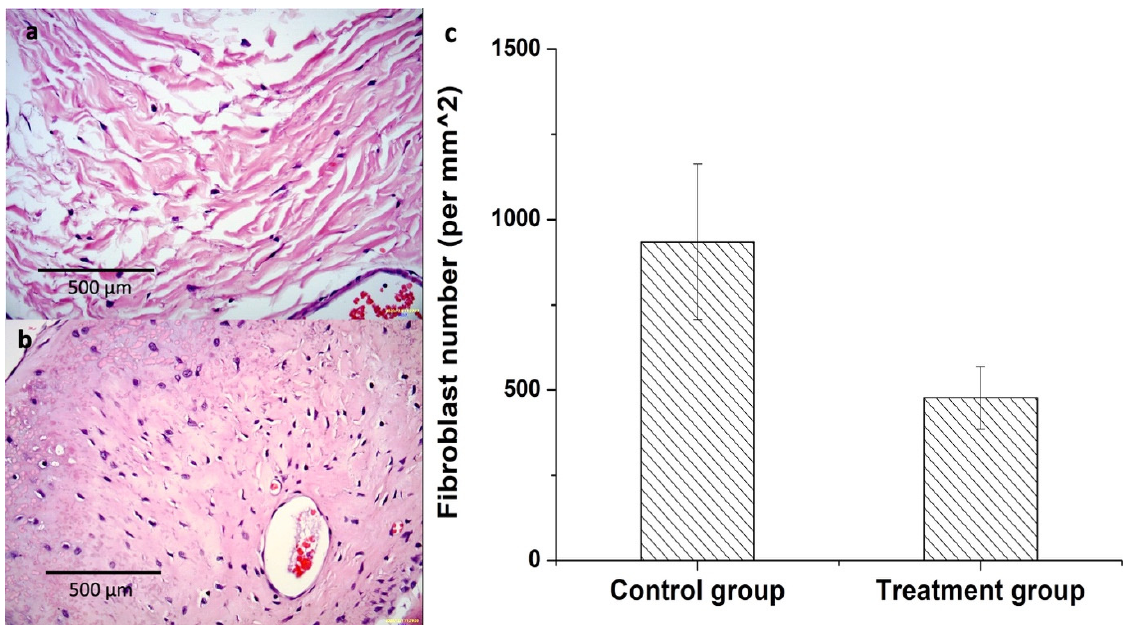
Figure 11. Histology results at 8 weeks post-laminectomy. 400× H&E-stained image of a specimen. ( a ) Treatment group showed significantly reduced number of fibroblasts in epidural defect in comparison with ( b ) the control group. ( c ) The average fibroblast count was 477 ± 91 per mm 2 in the treatment group and 935 ± 228 per mm 2 in the control group 8 weeks postoperatively (n = 10, mean ± SD).